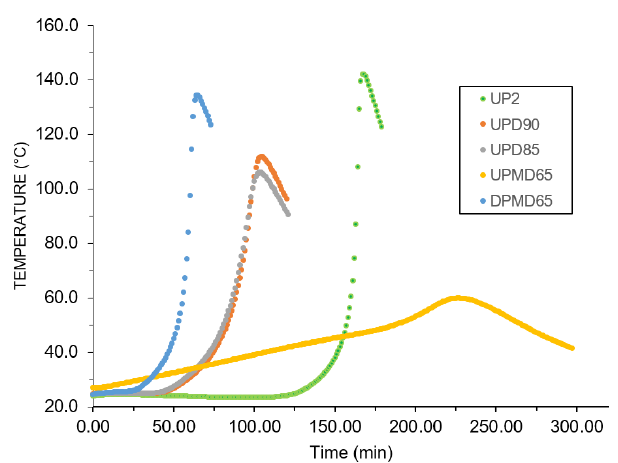
Figure 4. Temperature build-ups of the UPRs.